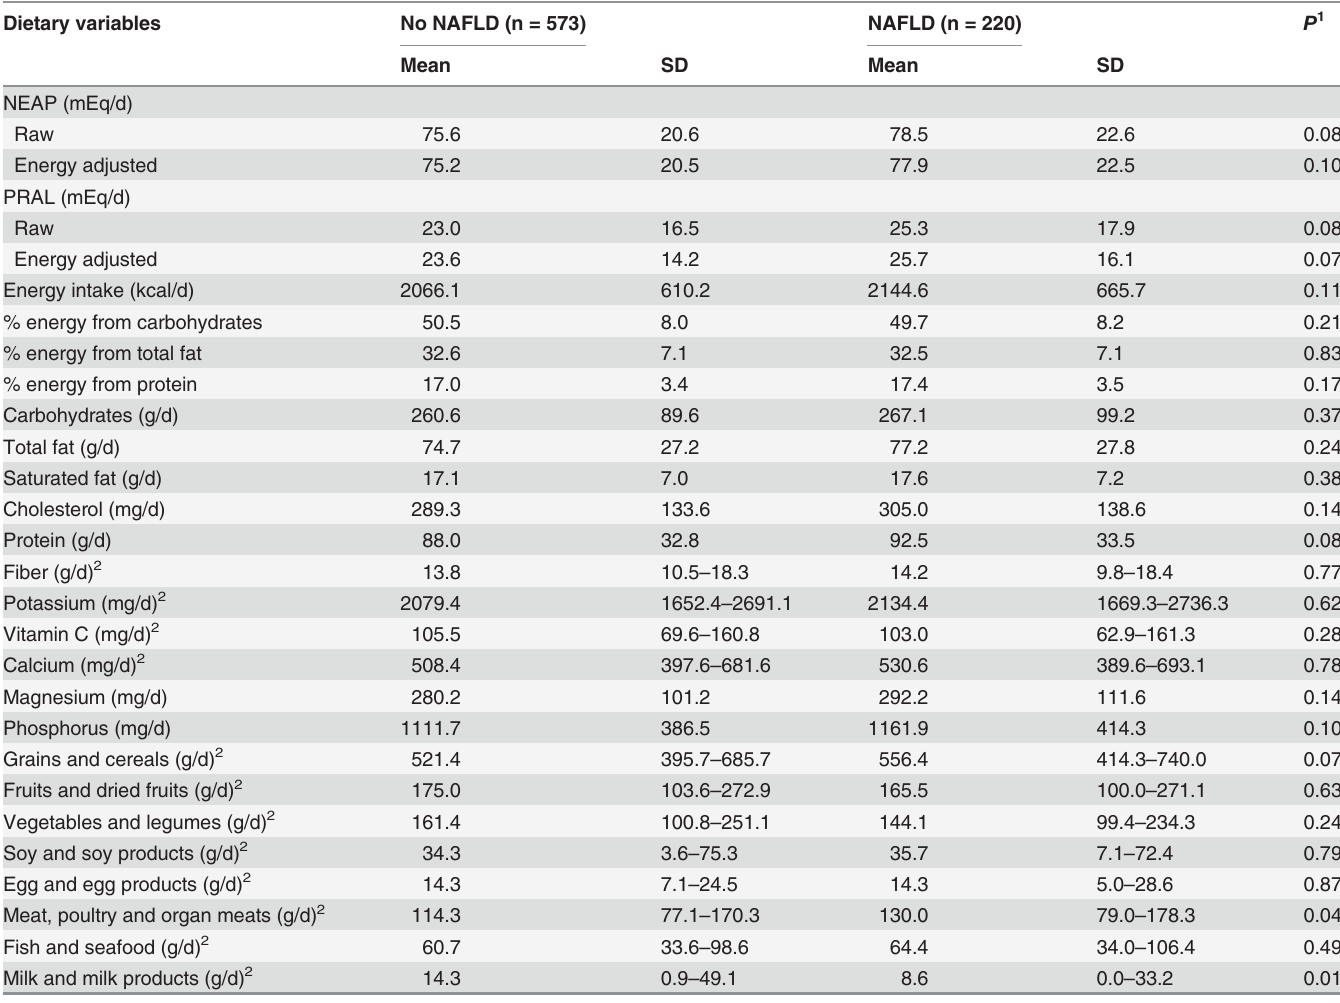
Table 2. Dietary acid load and intakes of selected nutrients and food groups between subjects with and without NAFLD (n = 793). Dietary